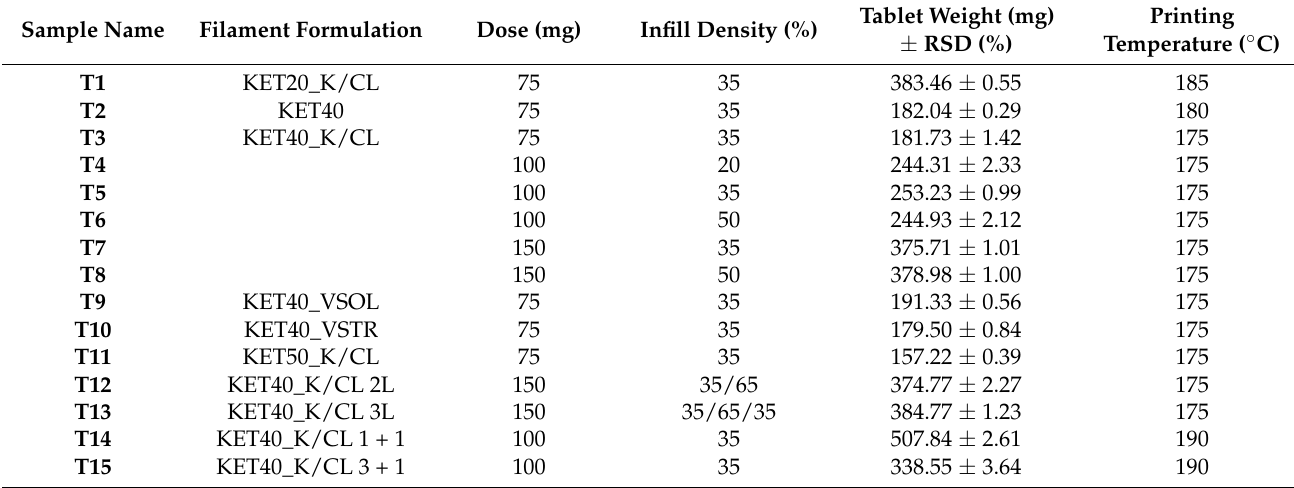
Table 2. Parameters of 3D printed tablets. RSD is the relative standard deviation.